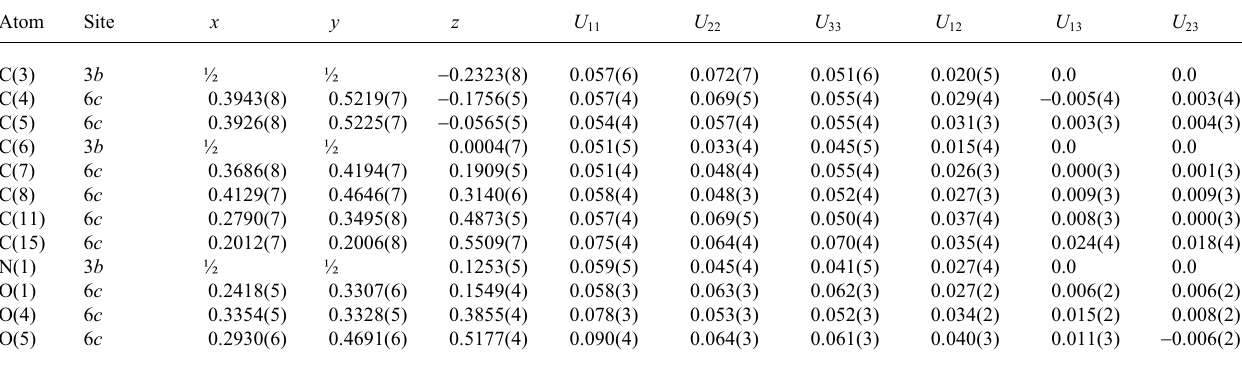
Table 3. Atomic coordinates and displacement parameters (in Å 2 )